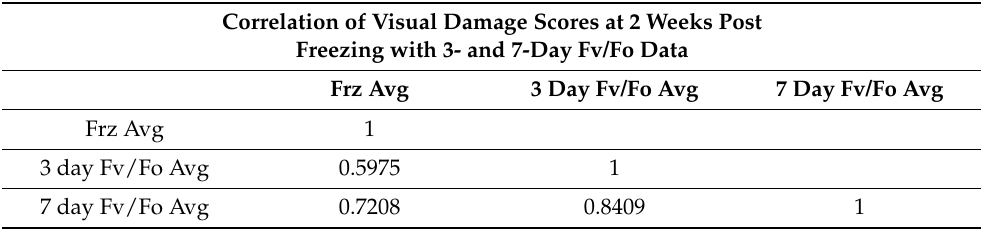
Table 1. Correlation coefficient between fluorometer readings (Fv/Fo) and visual damage scores